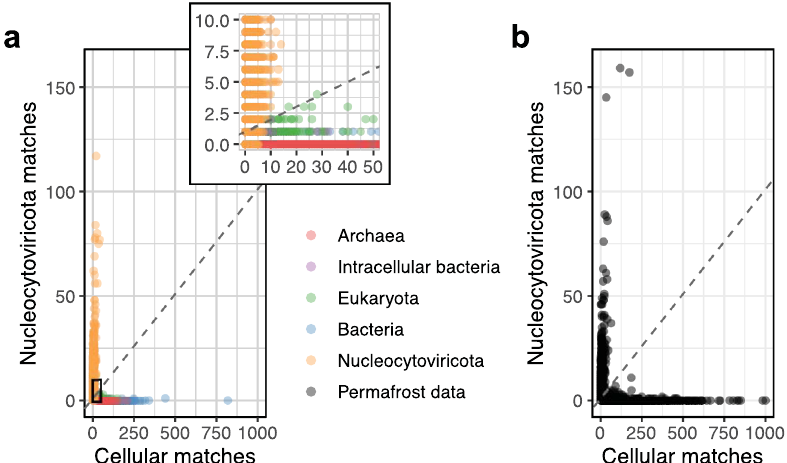
Fig. 1 | Viral scaffolds fi ltering. Each point corresponds to one scaffold. Viral matches ( y -axis) were counted as the number of ORFs matching a Nucleocytovir- icota -speci fi cHMMatan E valueof10 − 10 .TheseHMMscomefromapreviousstudy 18 to which were added speci fi c HMMs from the VOG database and HMMs con- structedon Pandoraviridae and Pithoviridae genomes.Cellularmatches(x-axis)are the number of DIAMOND BLASTP matches against the cellular RefSeq database